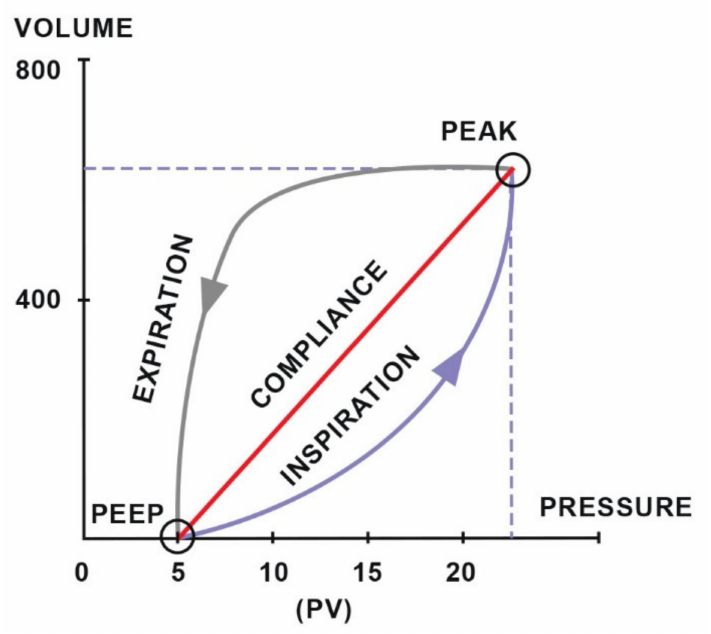
Figure 5. The compliance loop demonstrates the relationship between pressure and volume. Adapted with permission from [86] Copyright 2010 Y.P.S.